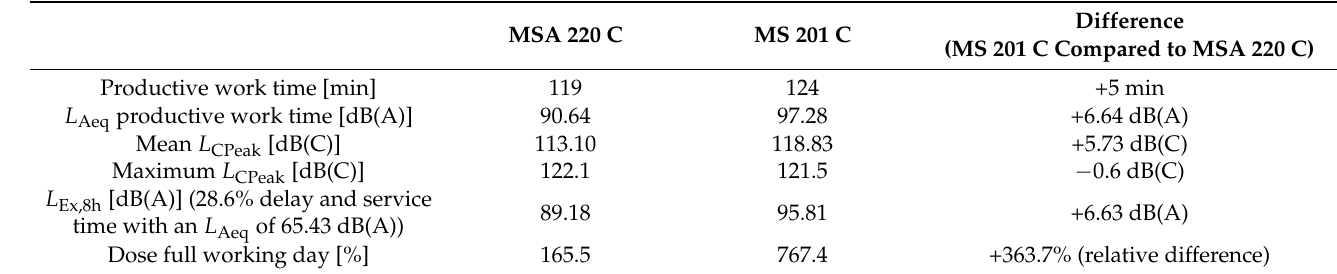
Table 4. Summary of noise measurements.